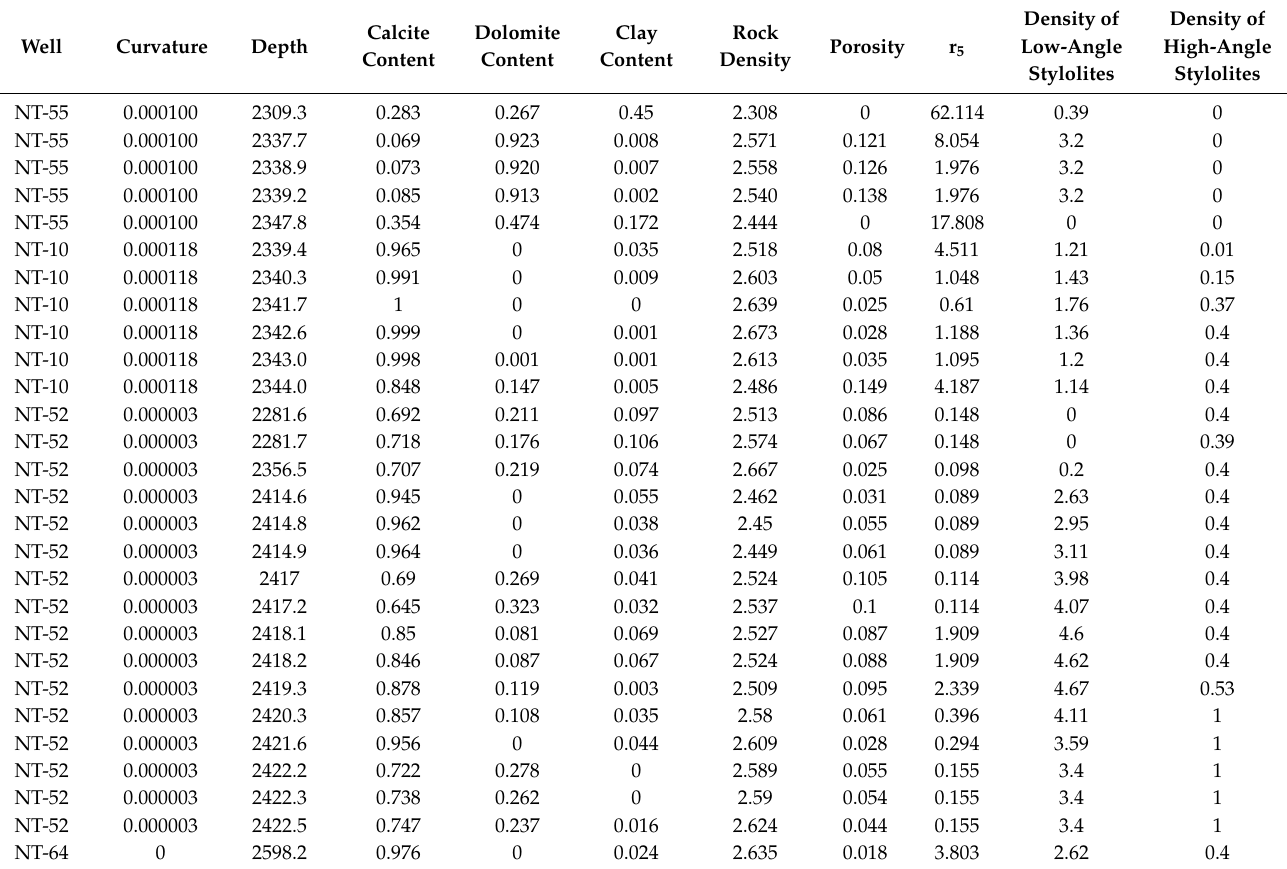
Table 2. Raw data of density of stylolite and controlling